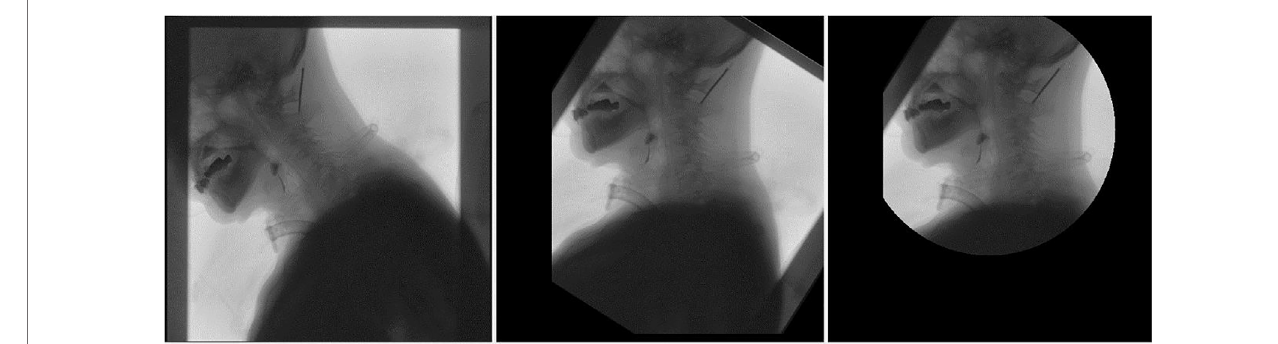
FIGURE 1 | Rotation renderings of pictures.